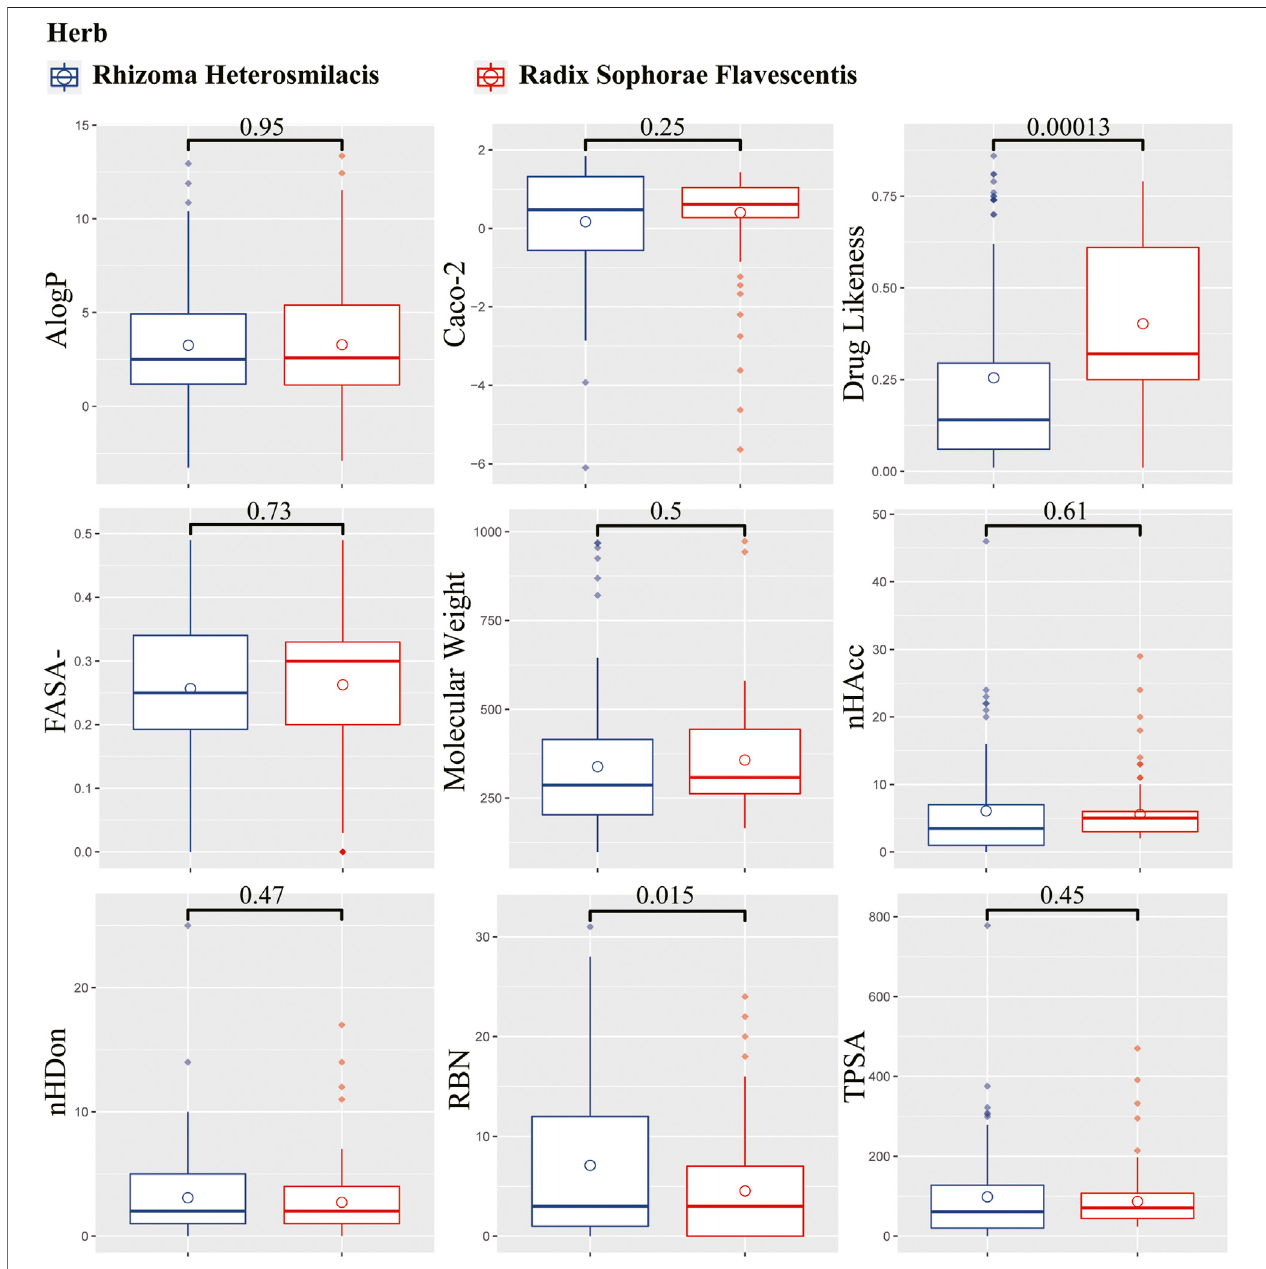
FIGURE2| Boxplotofnineproperties ofthetwocomponents. Theboxinbluerepresentsthevaluedistributionof RadixSophorae Flavescentis ,andtheboxinred represents the value distribution of Rhizoma Heterosmilacis .